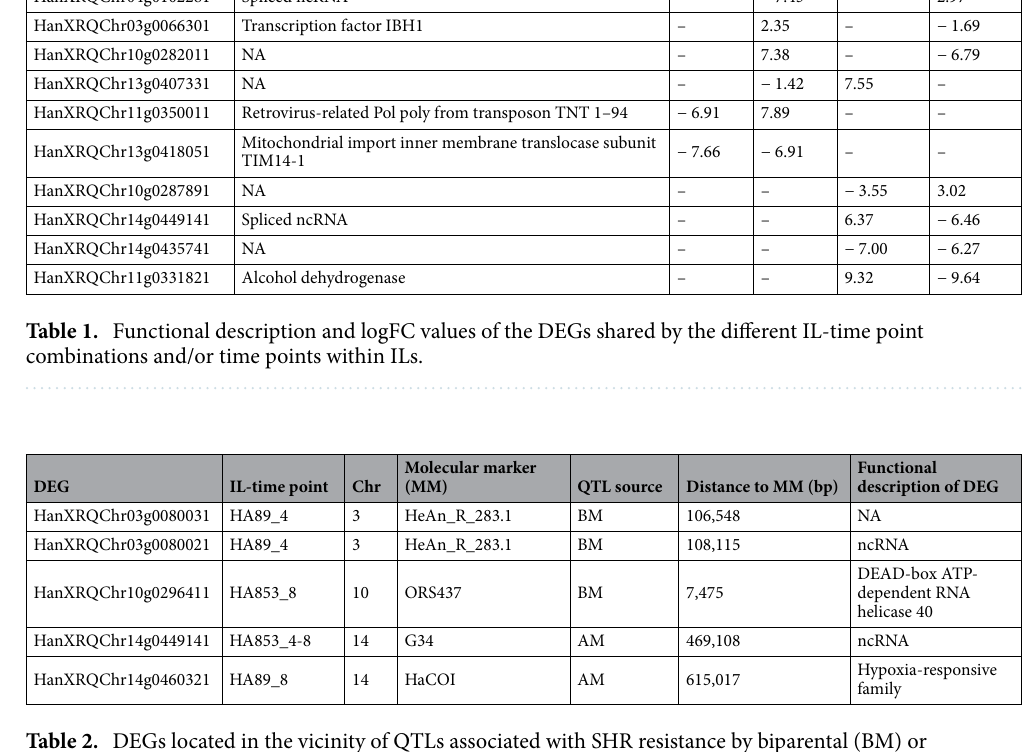
Table 2. DEGs located in the vicinity of QTLs associated with SHR resistance by biparental (BM) or association (AM) mapping.